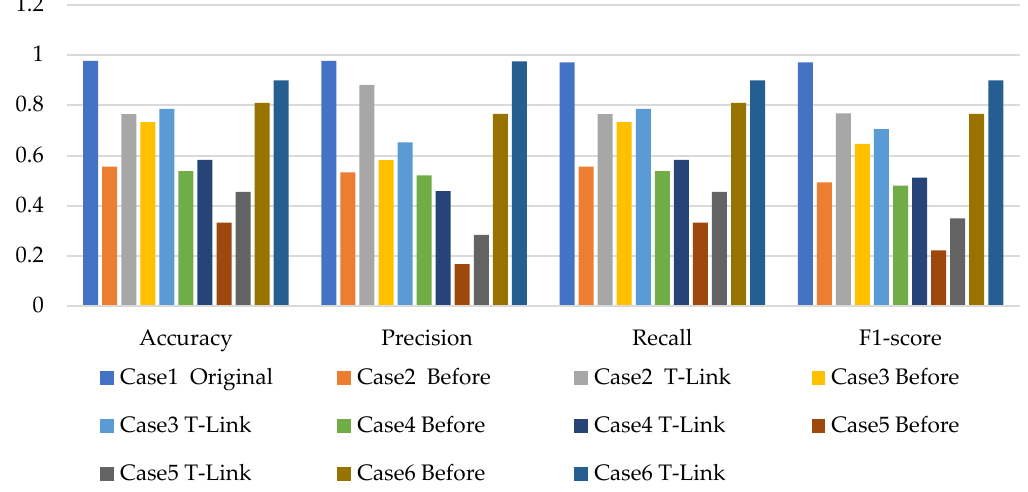
Figure 21. Experimental performance of k-NN classification with T-link.